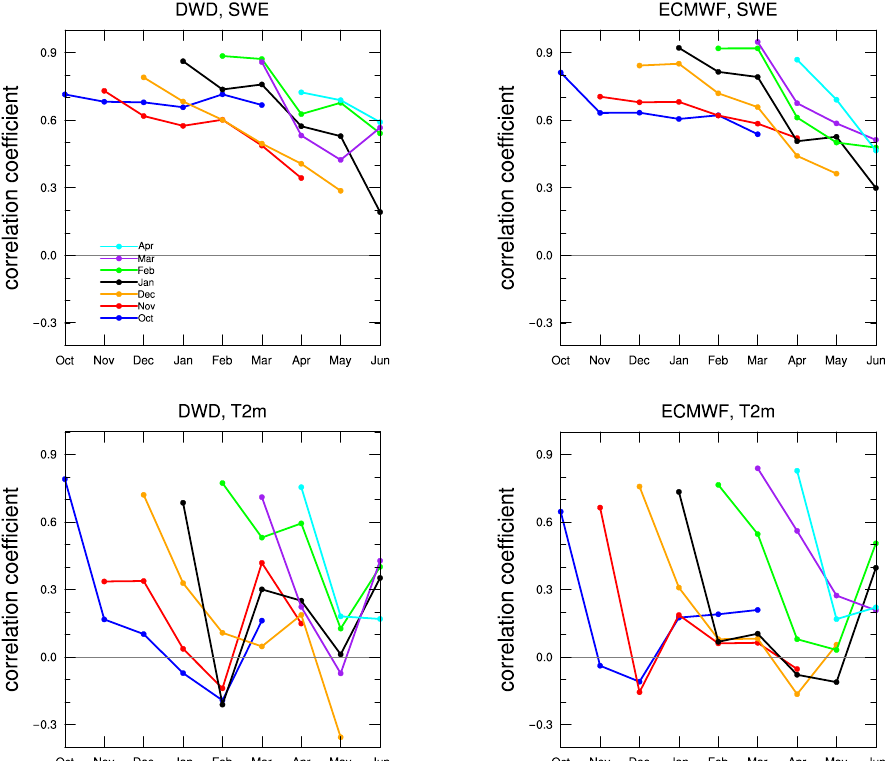
Figure 5. Pearson correlation for SWE and 2-m temperature of monthly data from hindcasts (1993 to 2016) with ERA5 as reference. Values were first averaged over the region before calculating the Pearson correlation coefficient. Colors indicate different starting months.